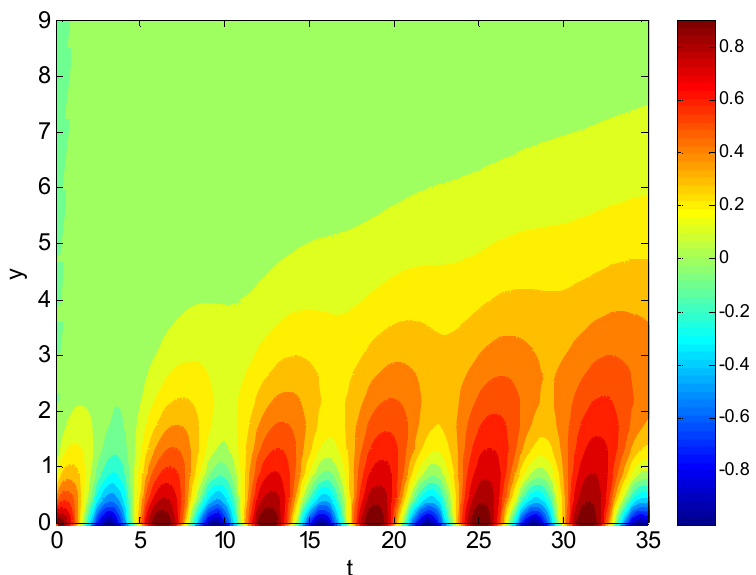
Figure 8. Contours of velocity profile for Stokes second problem.